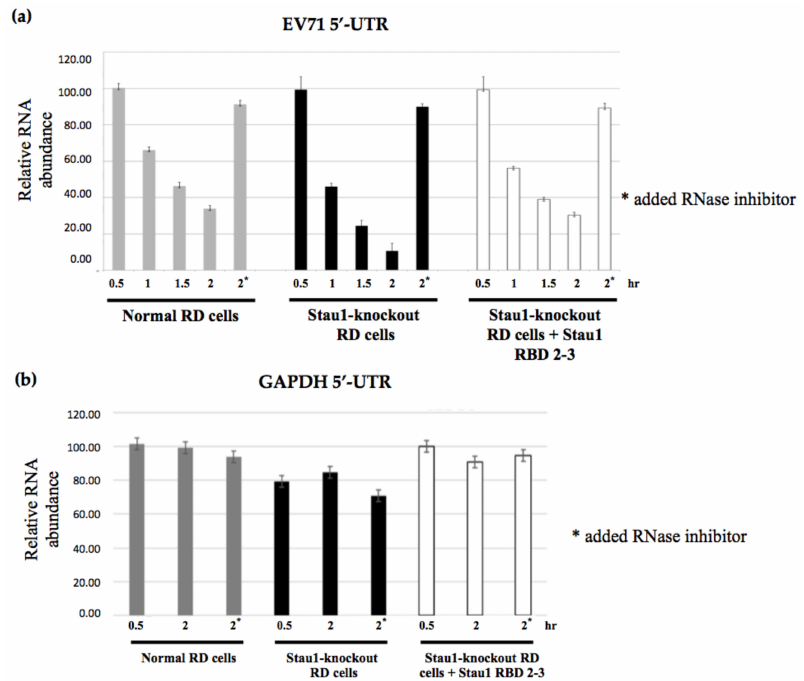
Figure 7. Stau1 improves the stability of 5 (cid:48) -UTR ofEV-A71 viral RNA. The 5 (cid:48) -UTR of EV-A71 RNA was transfected in the normal, Stau1 knockout, and recombinant Stau1-overexpressed RD cells for the viral RNA stability assay. The transfectant cell lysates were then harvested at 30 min posttransfection for the RNA stability assay. RNase inhibitor was added for the negative control as shown in * ( a ). The 5 (cid:48) -UTR of GAPDH RNA was used as the experimental control ( b